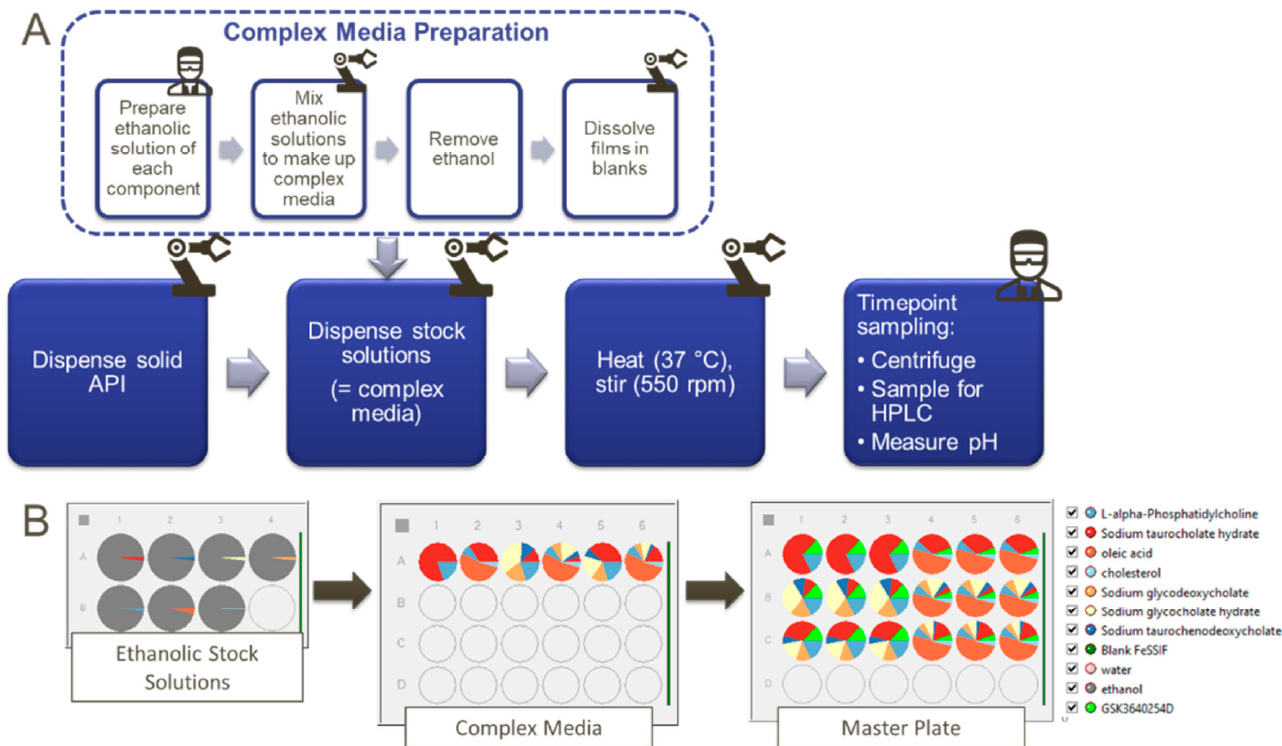
Figure 1. ( A ) Workflows schematic for preparation of complex biorelevant media ( top , dashed box) and for biorelevant solubility experiment ( bottom ). The icons on top of each box indicate if the step is run manually (scientist icon) or on an automated platform (robotic arm icon); ( B ) Example of plate designs highlighting the ratio of the various biorelevant media components and API as pie-charts for each plate position. NOTE: blank FeSSIF buffer is not shown for easier view of media